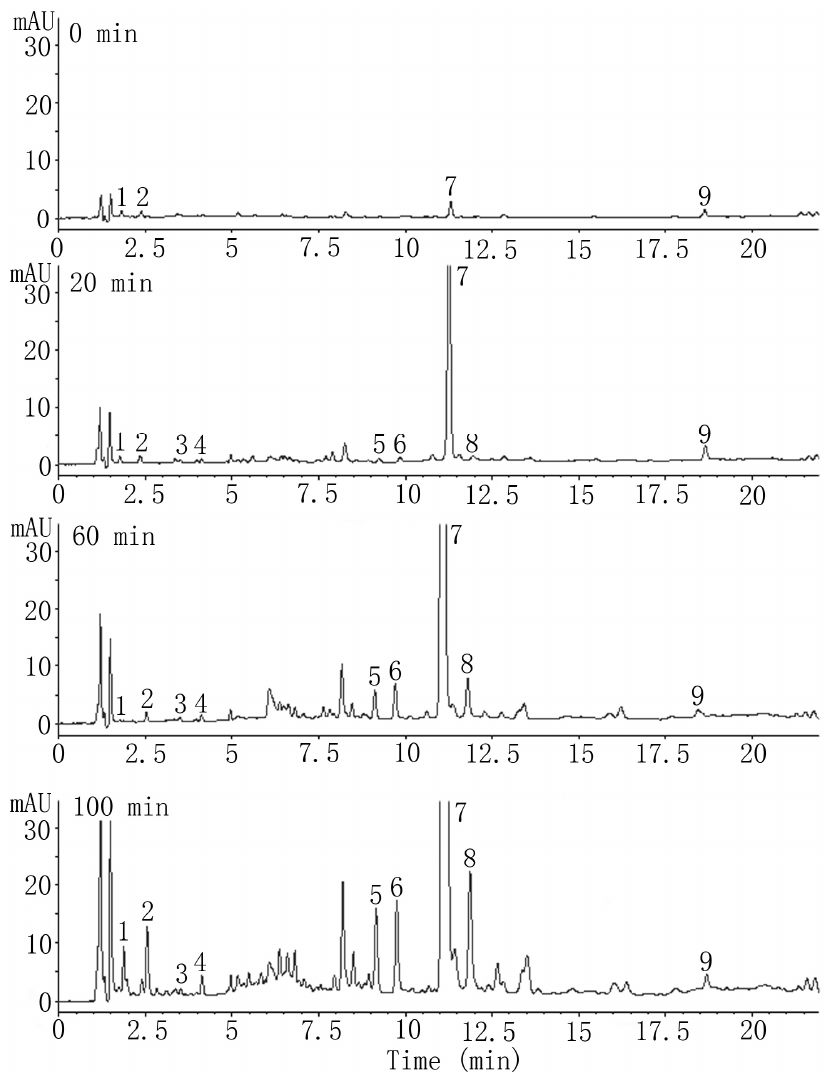
Figure 3. Typical chromatograms of salvianolic acid constituents in Danshen samples dried for different durations at 130 °C. Peak numbers represent: (1) DSS; (2) PA; (3) PD; (4) CA; (5) RA; (6) LA; (7) SaB; (8) SaA; and (9) SaC. See Figure 1 for analyte